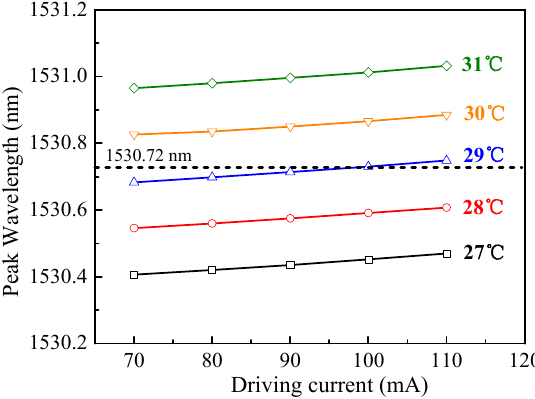
Figure 4. Tuning characteristics of the DFB diode laser.